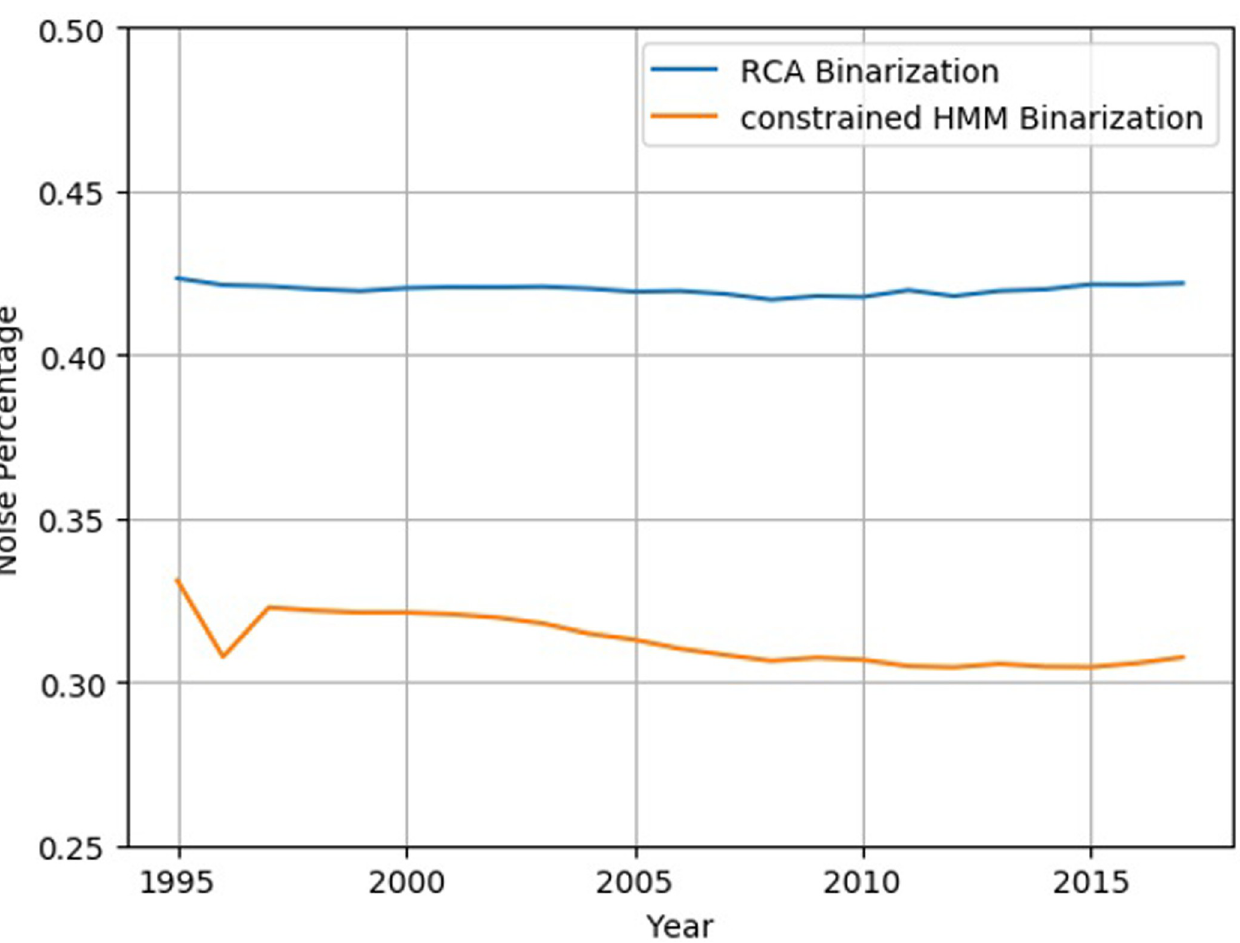
Fig 7. Noise estimation test. The blue line is the noise estimation of RCA binarization and the orange one is the noise estimation of SDC-HMM. The average data noise percentage of the RCA binarized data obtained by noise estimation is higher than the average value of data noise after SDC-HM optimization.